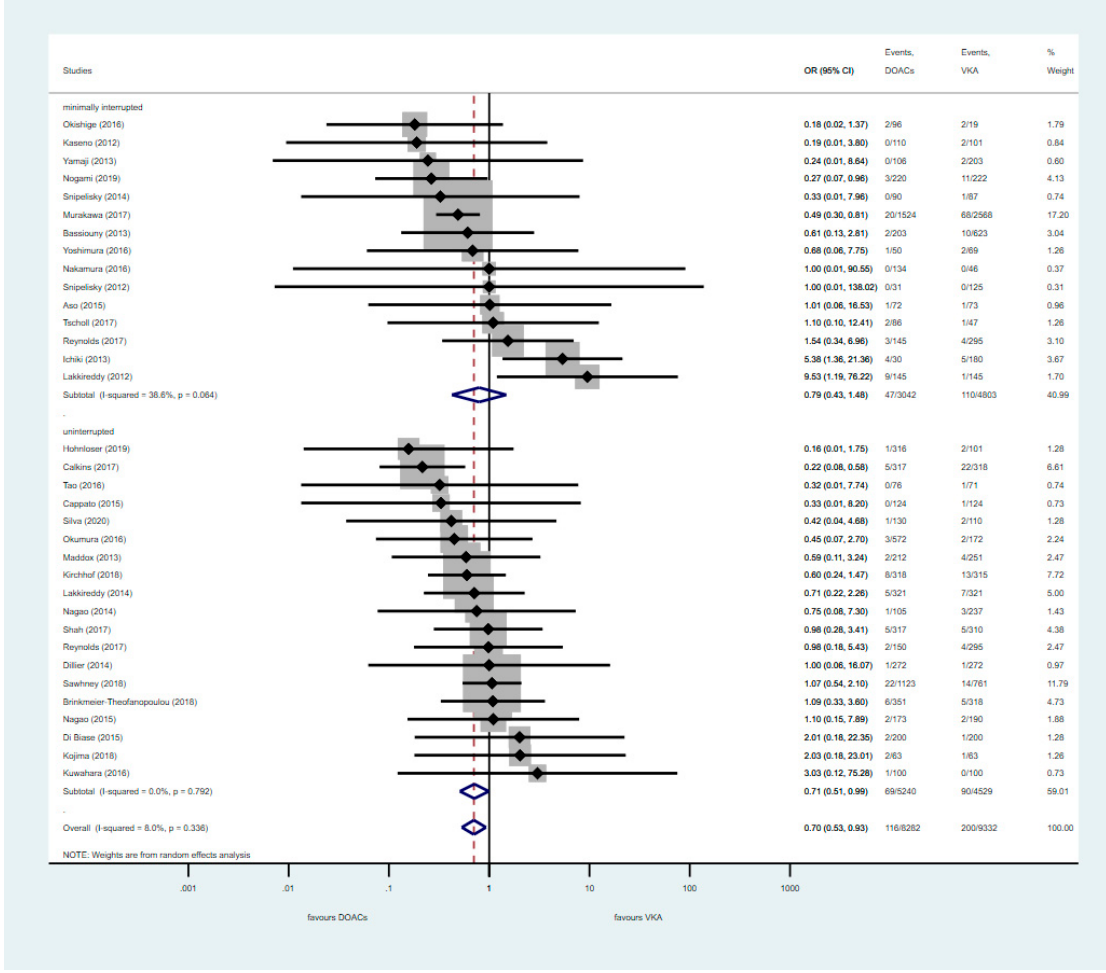
Figure 2. Primary efficacy outcome of stroke or transient ischemic attack (TIA) with uninterrupted or minimally interrupted DOAC strategies vs. VKA. CI: Confidence Interval; OR: Odds Ratio; DOAC: Direct Oral Anticoagulants; VKA: vitamin K antagonist. The diamond defines the overall result of each given group, the dotted red line is there to graphically show the overall results of the groups Major bleeding events were significantly reduced in the uninterrupted DOAC group compared to the VKA group (POR: 0.71, 95% CI: 0.51–0.99), while minimally interrupted therapy did not reach